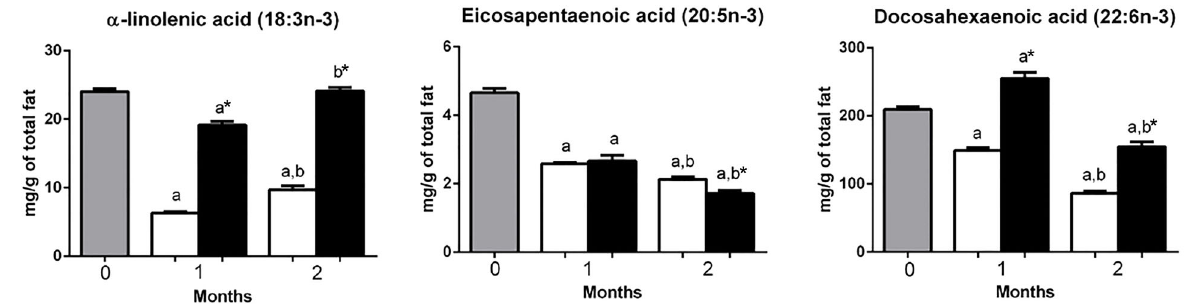
Figure 5. Polyunsaturated n-3 fatty acids (n-3 PUFAs) composition in the gastrocnemius muscle of mice at 0 (before starting the diets, gray bars) or fed with a high-carbohydrate diet (HCD, white bars) or high-fat diet (HFD, black bars) for 1 or 2 months. The contents of n-3 PUFAs are reported as means ± SE. *P o 0.05 compared to HCD group (Student ’ s t-test). a P o 0.05 compared to time 0; b P o 0.05 compared to 1 month (one-way